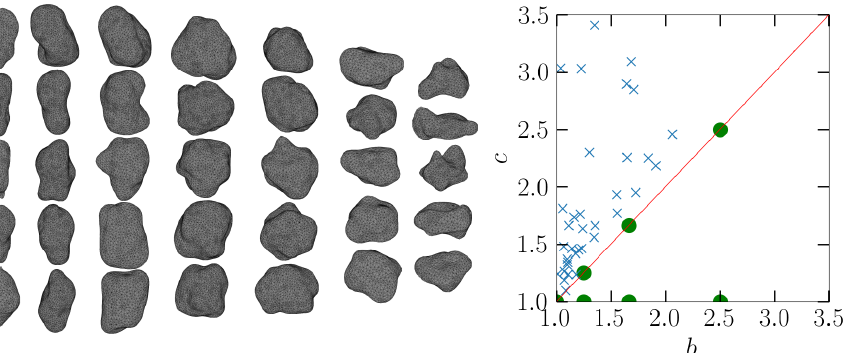
Fig 9. The Gaussian spheroid sample (left) and (right) axis ratios of ellipsoids with the same principal inertial properties as of the Gaussian spheroid sample. The dots represent the undeformed base shapes, which are only 7, and crosses the axis ratios needed to sample. The axis ratios are normalized so that a = 1. All values lie in reality in the upper left triangle, and the dots are mirrored to the other side for visual